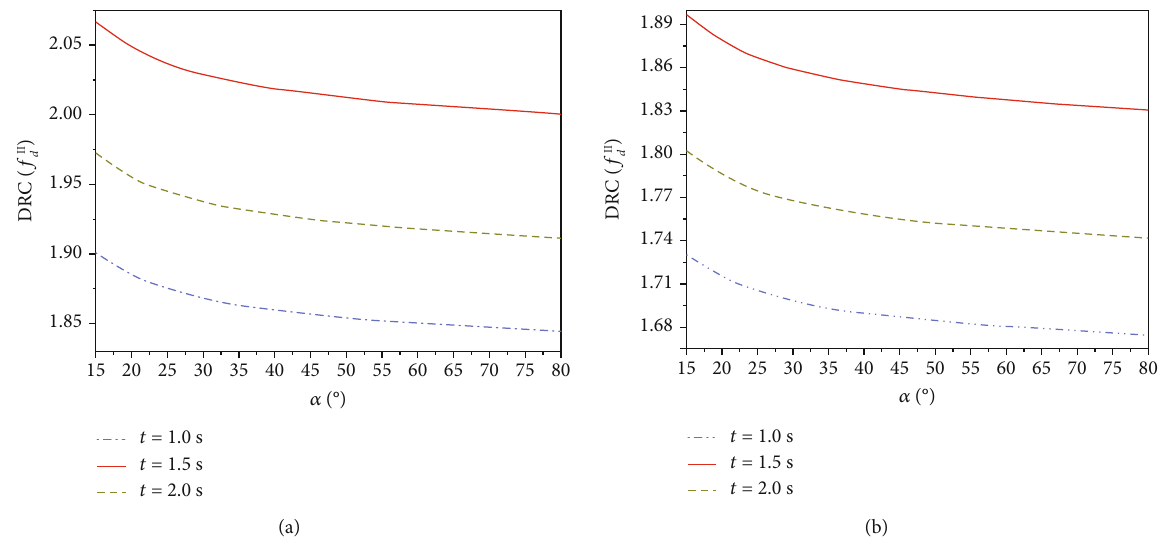
ΙΙ variations with crack inclination angle ( α ) at di ff erent times. (a) s = a . (b) s = 1 : 5 a Figure 11: f d